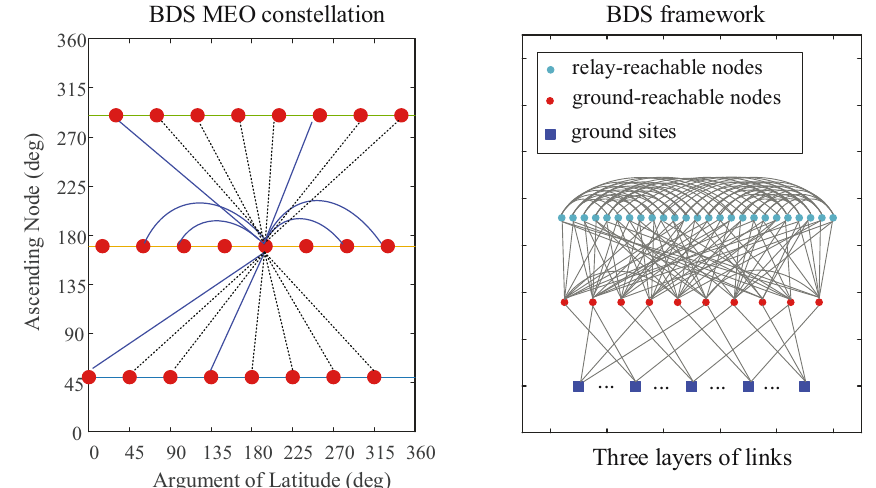
Figure 1: BDS ISL: topology of an MEO satellite ( left ) and three layers of links ( right )